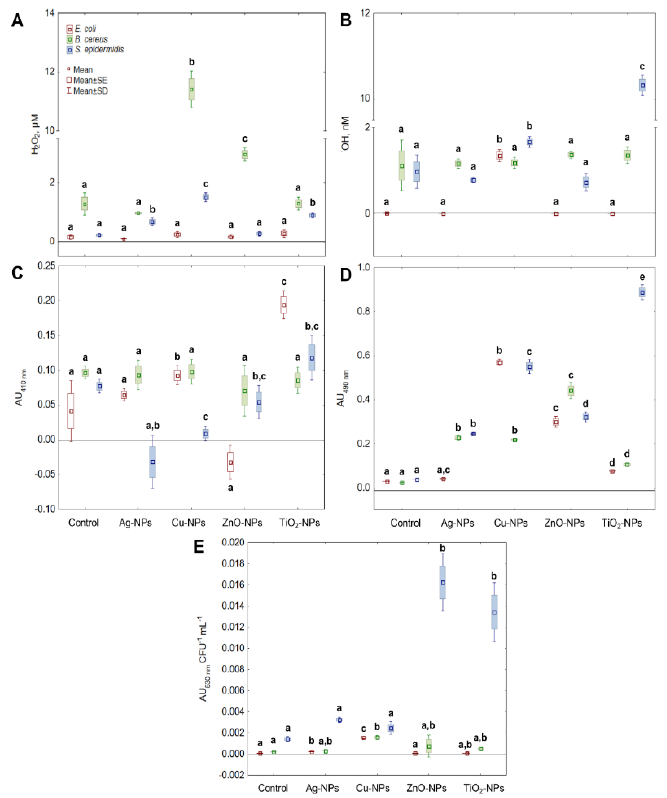
Figure 1. The levels of H 2 O 2 ( A ), • OH ( B ), 1 O 2 ( C ), O 2• − ( D ) and total ROS concentration ( E ) in E. coli , B. cereus and S. epidermidis exposed to NPs at an IC 50 value (mean ± SD/SE; n = 3). Means with the same letter(s) are not significant at p < 0.05 within each ROS between the control and NPs-treated samples.